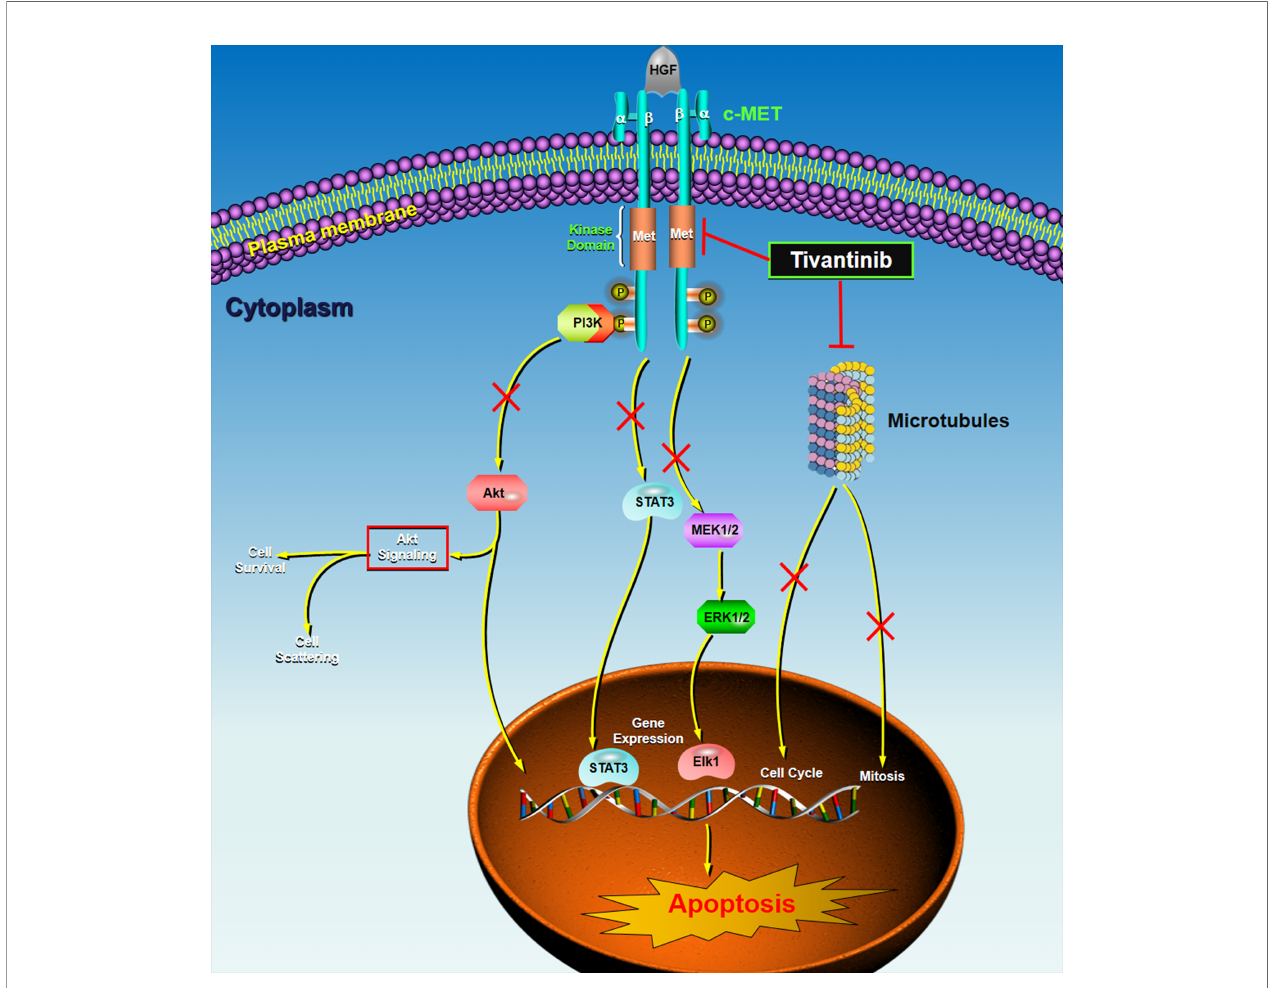
FIGURE 1 | The schematic diagram of the molecular mechanisms of tivantinib in treating HCC. c-MET is the high-af fi nity receptor for the HGF. c-MET is a single- chain precursor protein composed of extracellular a -subunit and a transmembrane b -subunit. The HGF/c-MET axis commonly dysregulates in cancers, including HCC. Tivantinib, a small molecule c-MET inhibitor, targets the inactive, unphosphorylated form of c-MET, locking it in the inactive con fi guration and suppressing downstream intracellular signaling pathways, such as PI3K-AKT, STAT3, and MEK-ERK. Also, tivantinib can directly bind microtubules, inducing mitotic catastrophe and cell cycle arrest by disrupting microtubule function or microtubule depolymerization. These actions driving by tivantinib independently or collectively contribute to subsequent apoptosis of the cancer cells. HGF, hepatocyte growth factor; MET, mesenchymal-epithelial transcription factor; PI3K, phosphoinositide 3-kinase; STAT, signal transducer and activator of transcription; MEK, mitogen-activated protein kinase kinase; ERK, extracellular signal-regulated kinase; P,